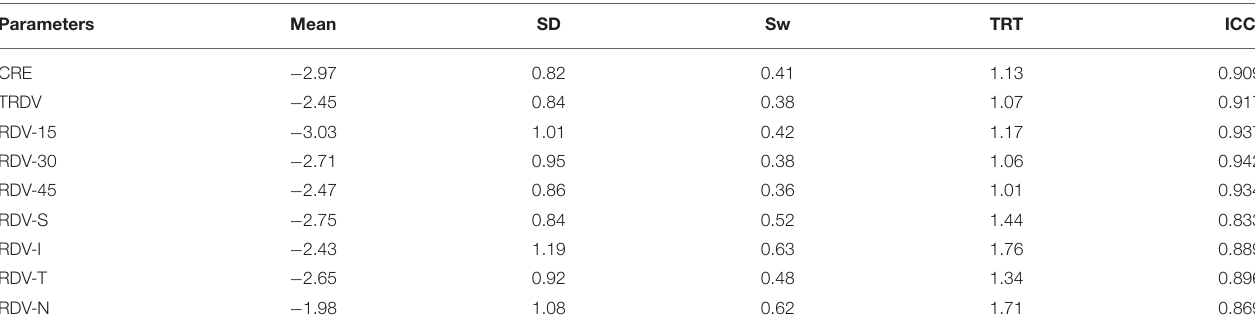
TABLE 3 | Intraobserver repeatability outcomes of central and peripheral refraction using MRT without cycloplegia of low myopia group. Parameters Mean